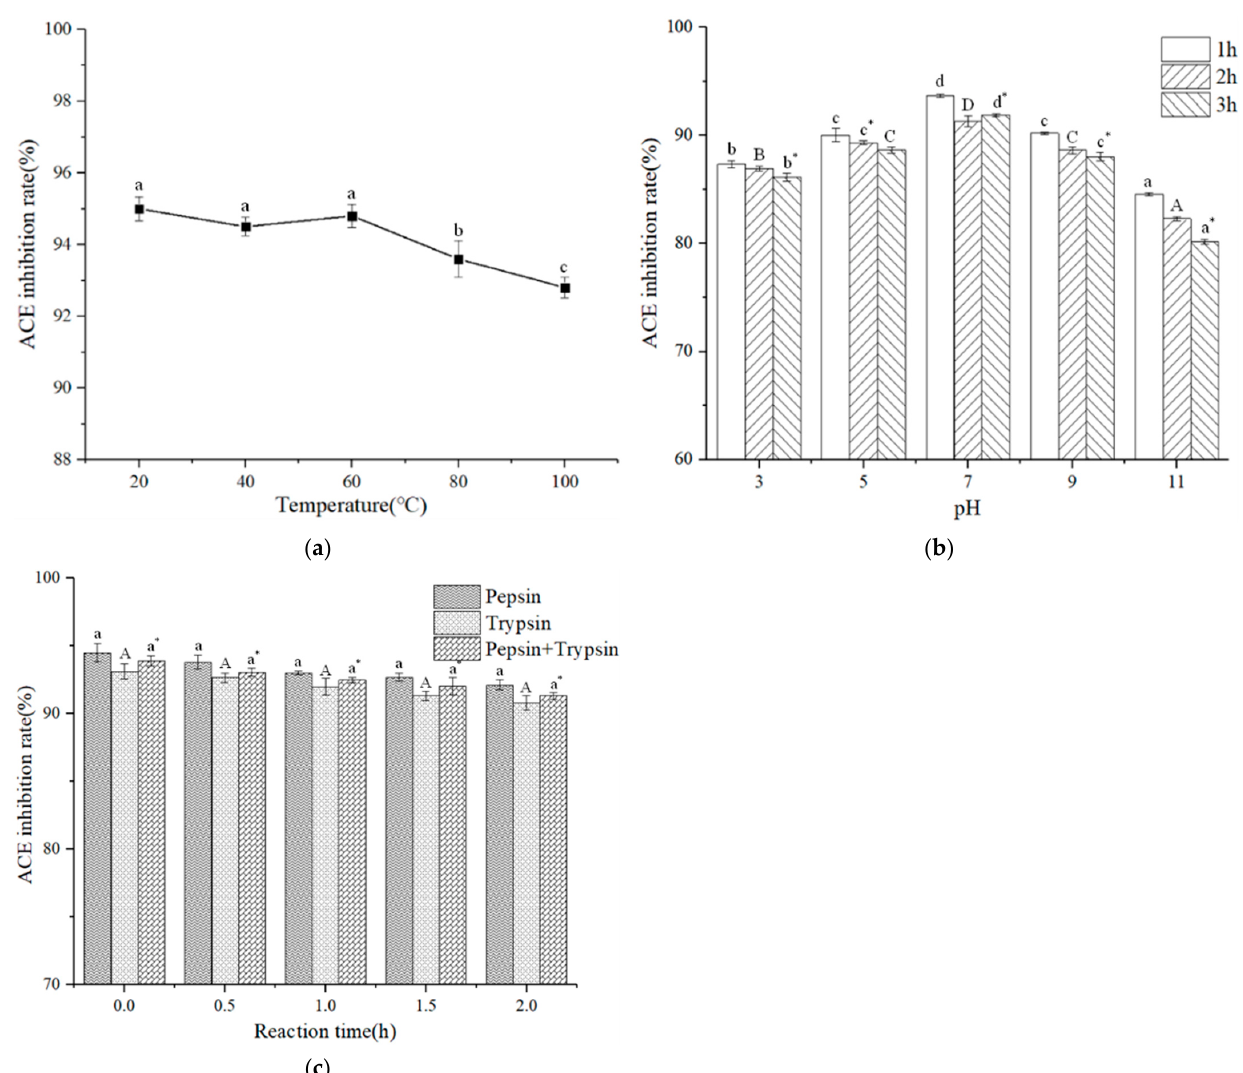
Figure 6. Stability of the DLTAGLLE. Effect of temperature ( a ), pH ( b ), and gastrointestinal digestion ( c ) on the ACE inhibitory activity of DLTAGLLE. The column values of A–C, a–c and a*–c* with the different superscript indicated a significant difference ( p < 0.05).